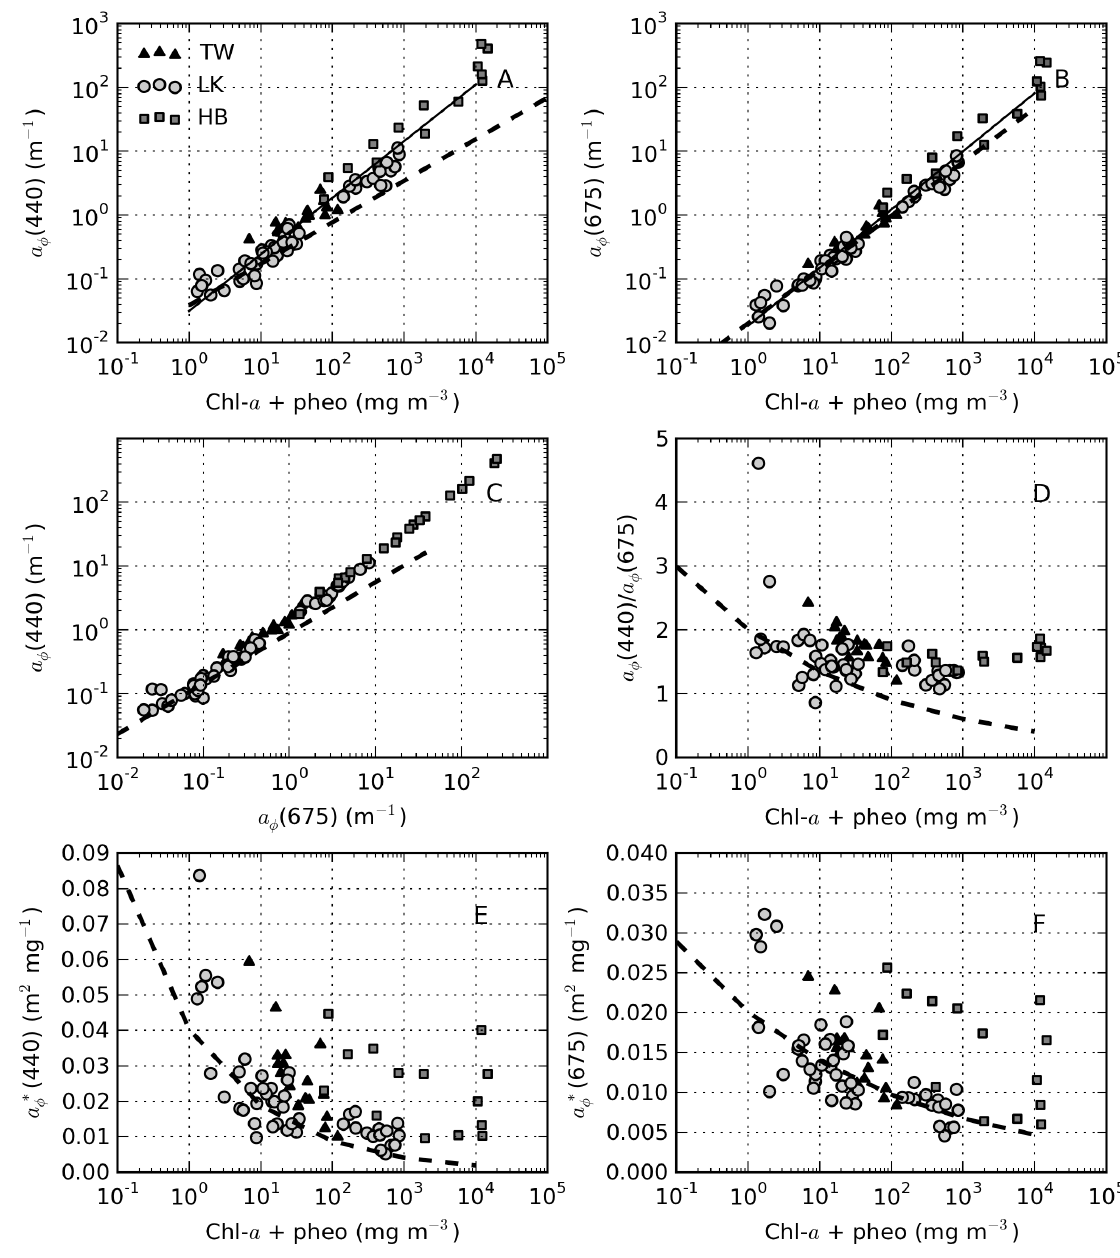
versus TChl at 440 nm and ( B ) 675 nm showing the best fit line (–); Figure 16. ( A ) a φ ( C ) a (442) versus a (675); ( D ) a (442): a (675) versus TChl; ( E ) a ∗ φ φ φ φ and ( F ) 675 nm. Dotted lines show the fits from Case 1 marine waters [4]. The legend is the same in all panels. Note the log